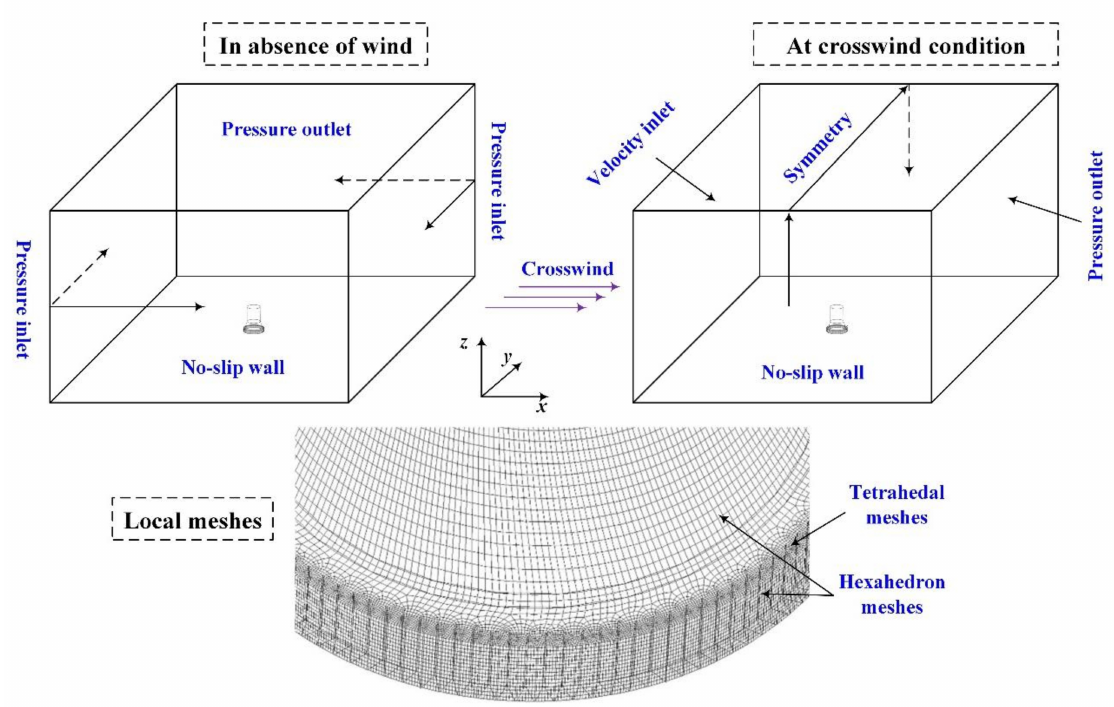
Figure 3. Illustrative computational domain of tower 2 with conical/cylindrical